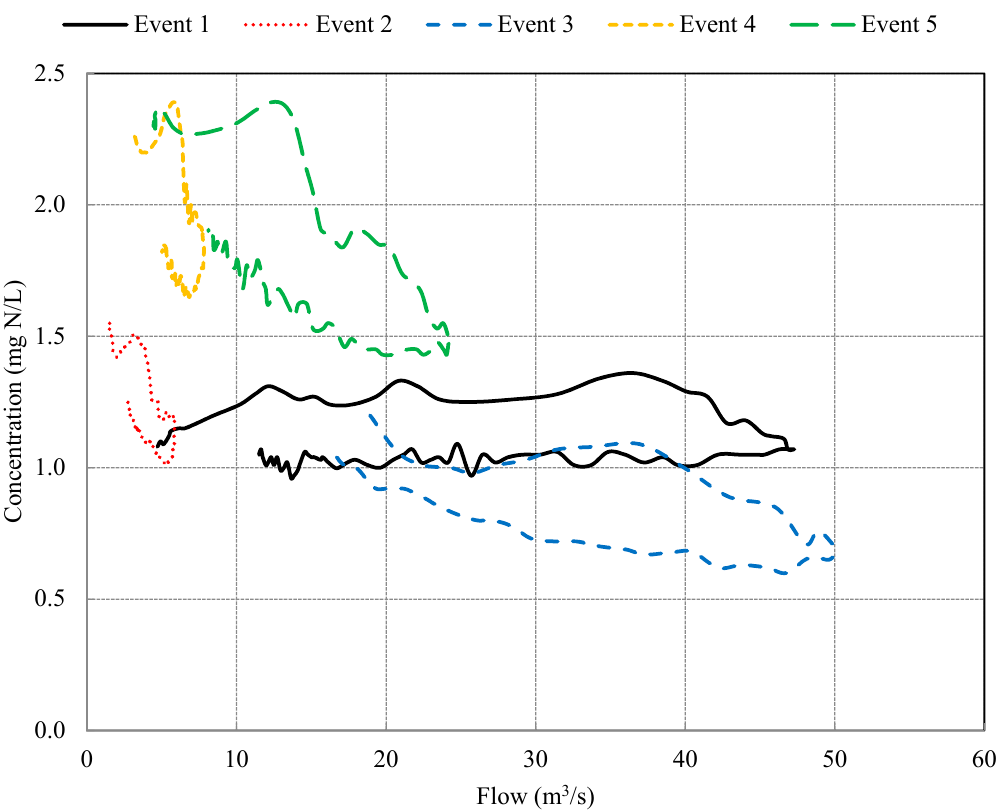
Figure 6. Hysteresis effect observed for five individual events of varying magnitude during the real- time monitoring period. (m 3 /s).